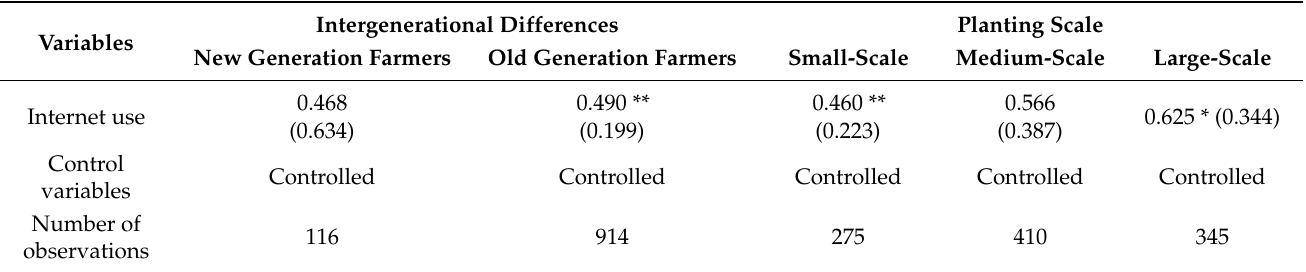
Table 5. Heterogeneity analysis